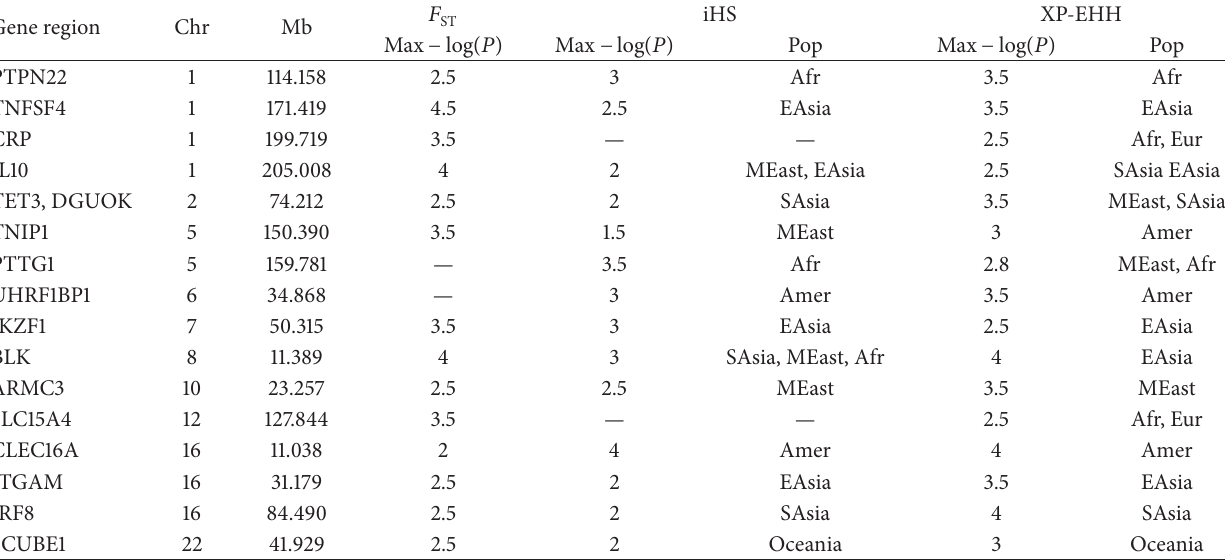
Table 3: Regions with evidence for selection in the HGDP